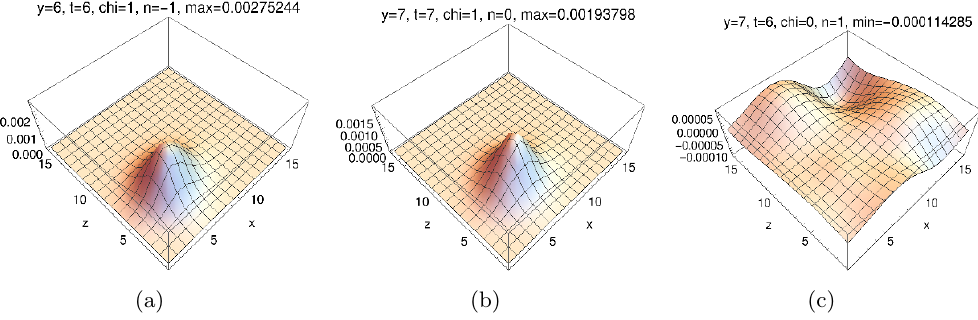
Figure 6 . The chiral densities (cid:31) n ( x ) of the (cid:12)rst three modes of the Q = (cid:0) 2 con(cid:12)guration in the x-z-planes through the points with the maximal (absolute) values of the chiral density. The plot titles indicate the plane positions, the chirality (chi=0 ; (cid:6) 1), the numbers n = # of plotted modes and the maximal (minimal) density in the plotted area, \max= : : : " (\min= : : : "). \ n = (cid:0) 1" means we plot the density (cid:31) (cid:0) 1 ( x ) for the mode with number #( (cid:0) 1). Note, to ease the comparison of the various modes in (cid:12)gure 5 we use the mode numbers #( (cid:0) 1) and #0 for the two zero-modes and start counting positive mode numbers for non-zero